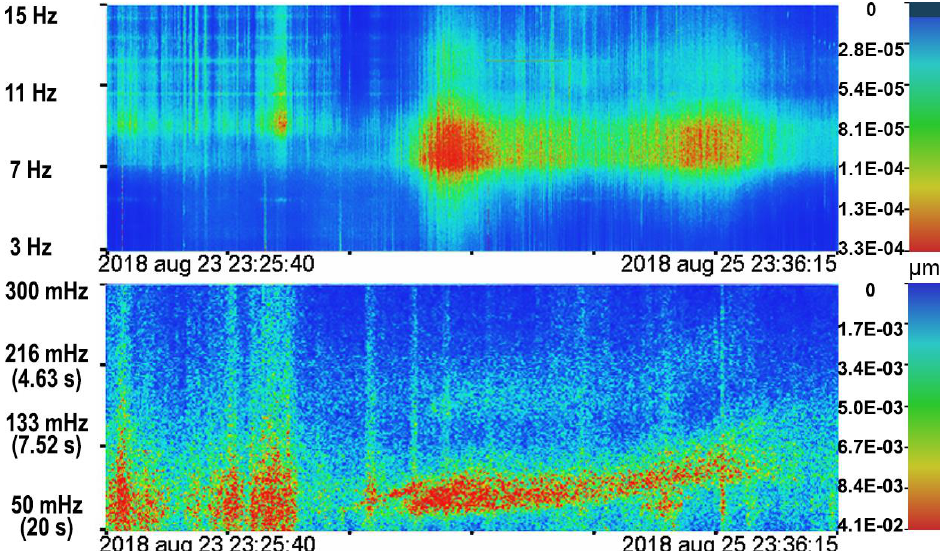
Figure 11. Dynamic spectrograms of laser strainmeter data during influence of Soulik typhoon.